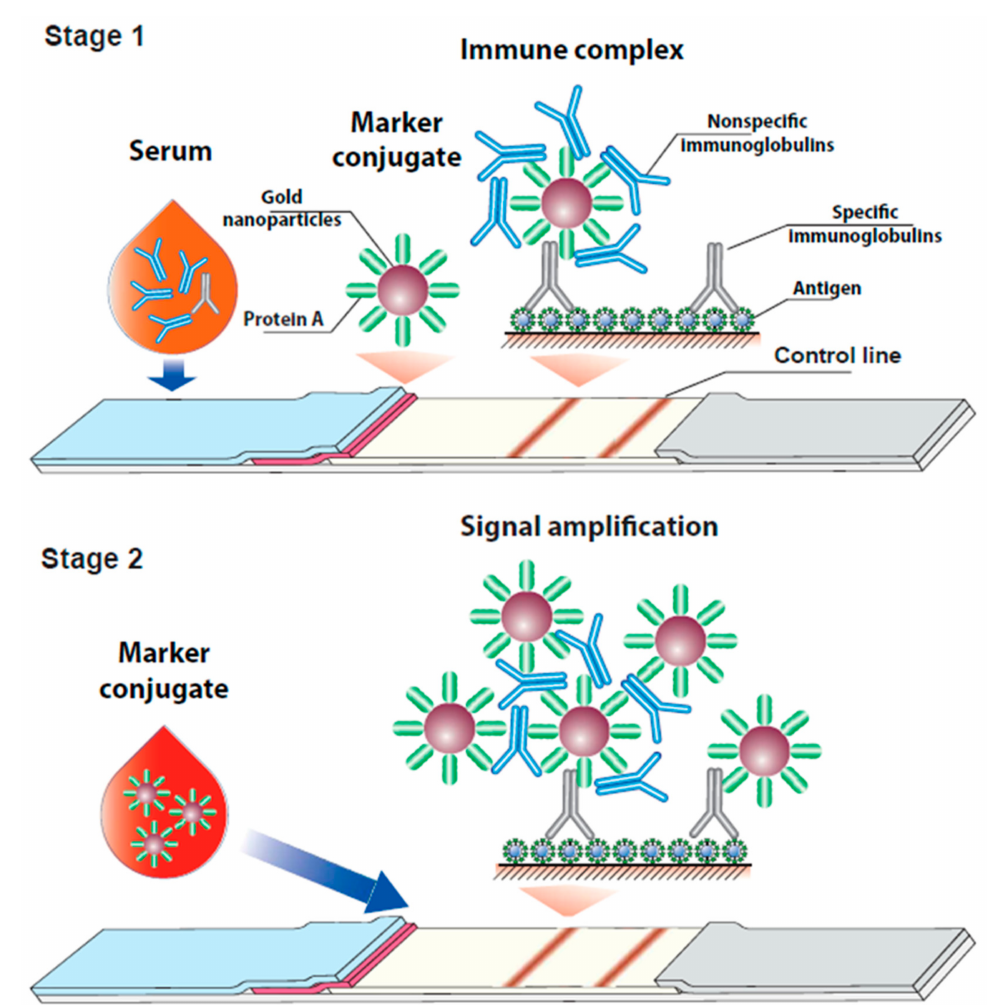
Figure 1. Scheme of the proposed enhanced serodiagnostic